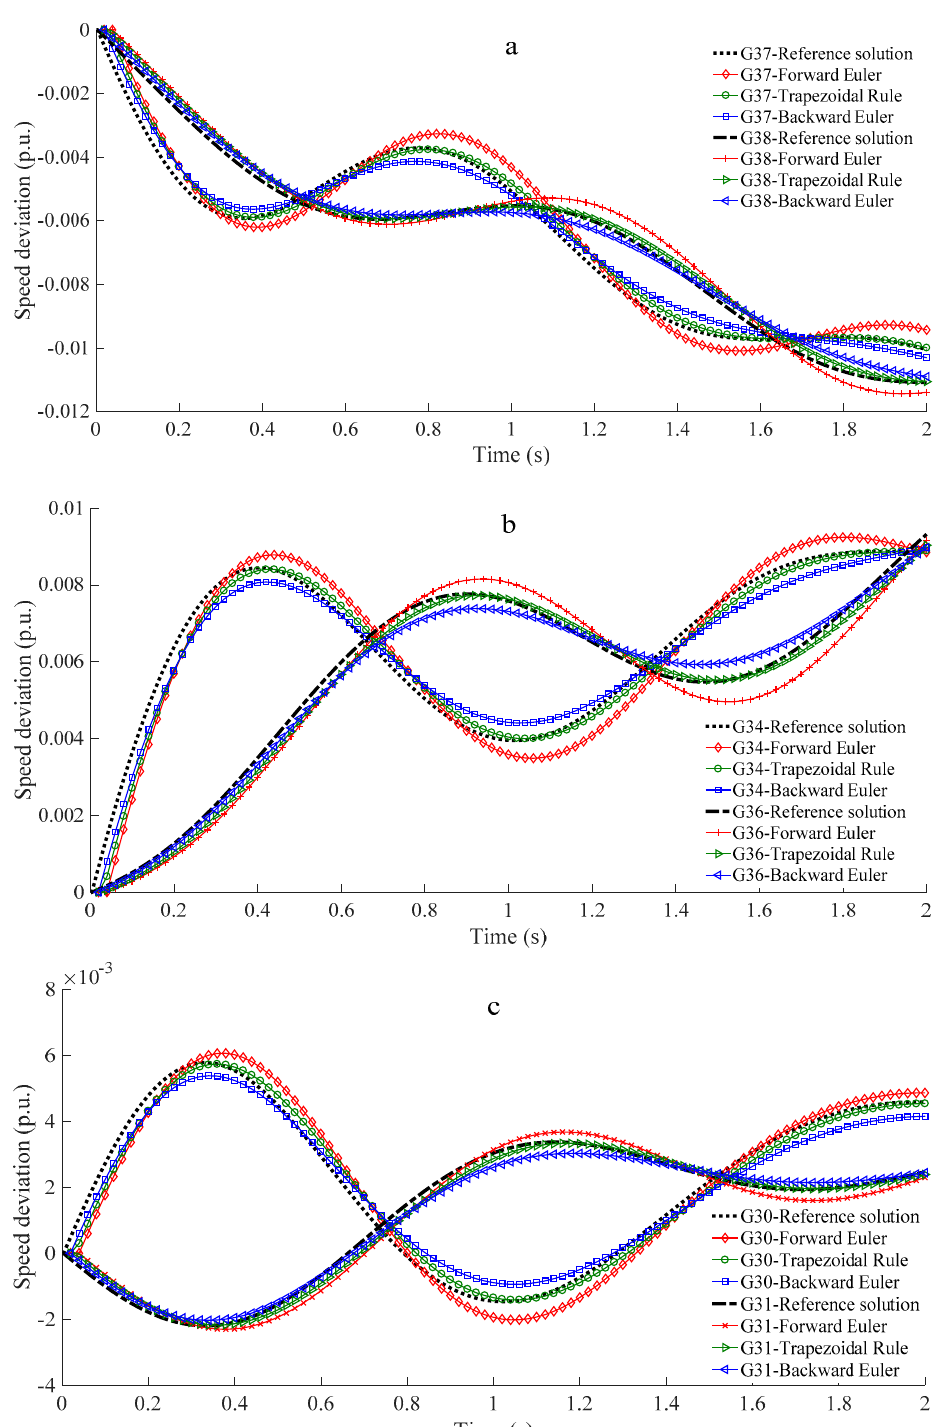
Figure 8. Rotor speed deviation of generators. ( a ) Generators 37 and 38 when a power outage of generator connected to bus 30. ( b ) Generators 34 and 36 when the loss of the load connected to bus 20. ( c ) Generators 30 and 31 when the loss of line 2–3.